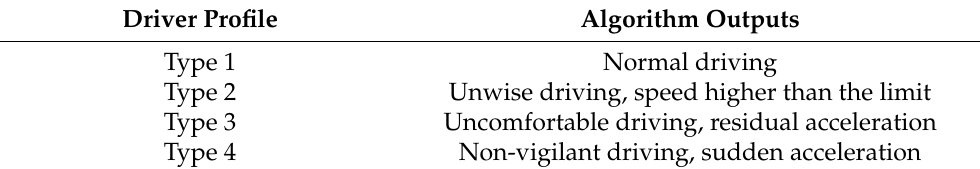
Table 4. Results of phase 1 for the four driver